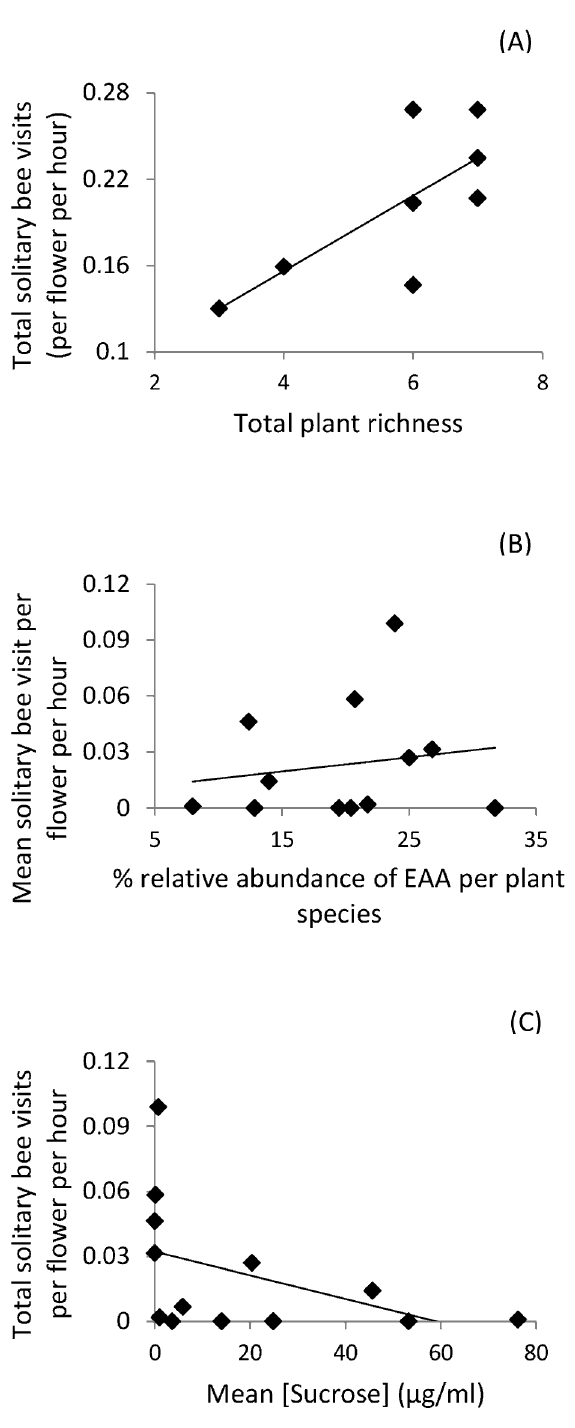
F IGURE 6. The relationship between total solitary bee visits per flower per hour and (A) total floral richness (r = (B) total relative abundance of EAA (%) (r = 0.30 (C) mean sucrose concentration (µg/ml) (r =